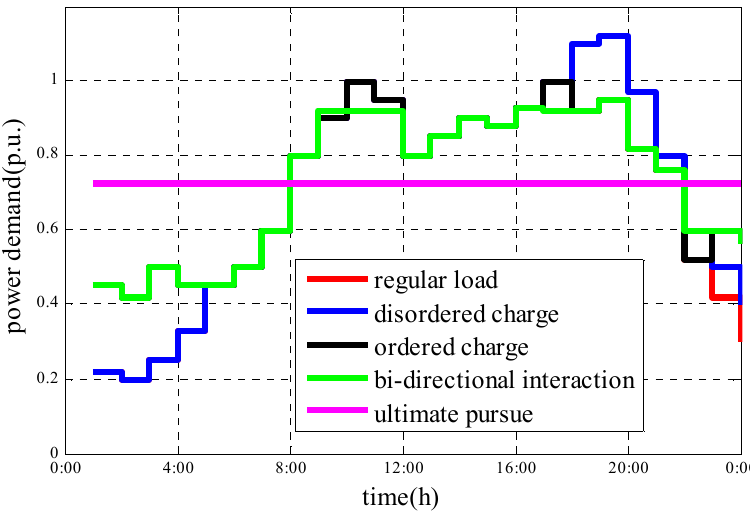
Figure 7. Roadmap of the development of PHEVs/EVs under